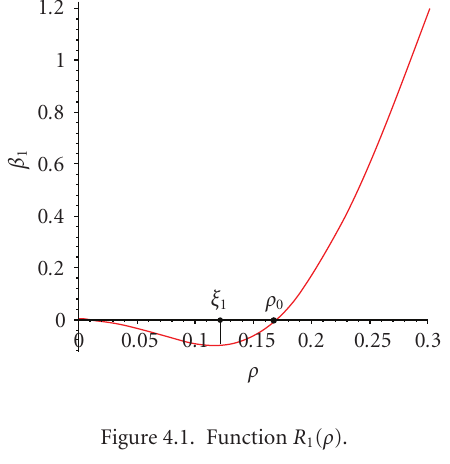
Figure 4.1. Function R 1 ( ρ